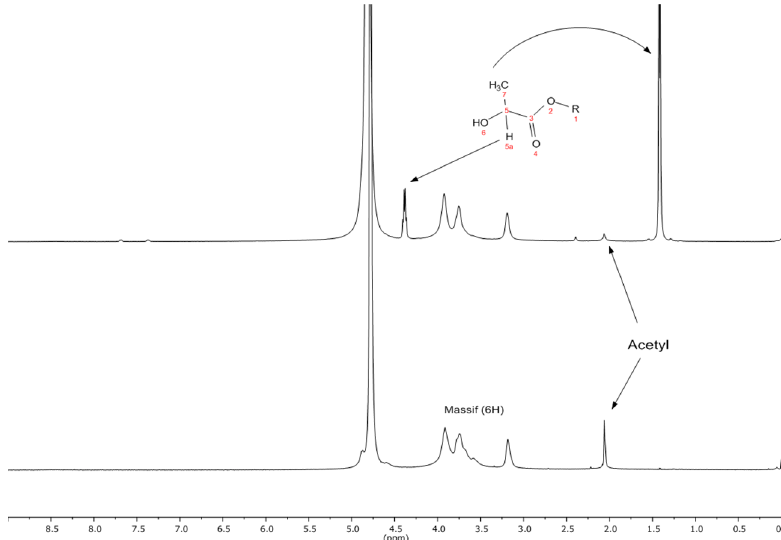
Figure 1. 1 H-NMR spectra of Ch ( bottom ) and ChLA-TSA ( top ).